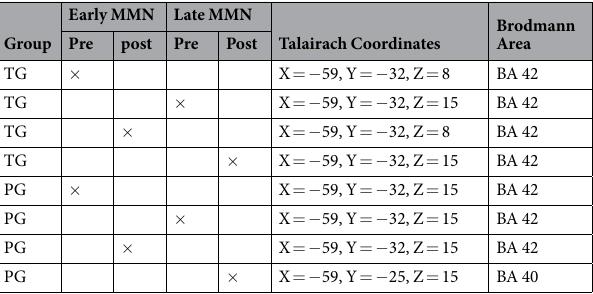
Table 1. Reconstructed source maxima of the MMN responses in the time windows between 100-200 (spectral manipulation, early MMN) and 200-300 ms (temporal manipulation, late MMN) for the two groups (TG and PG) and the two time points (pre = T0 and post =